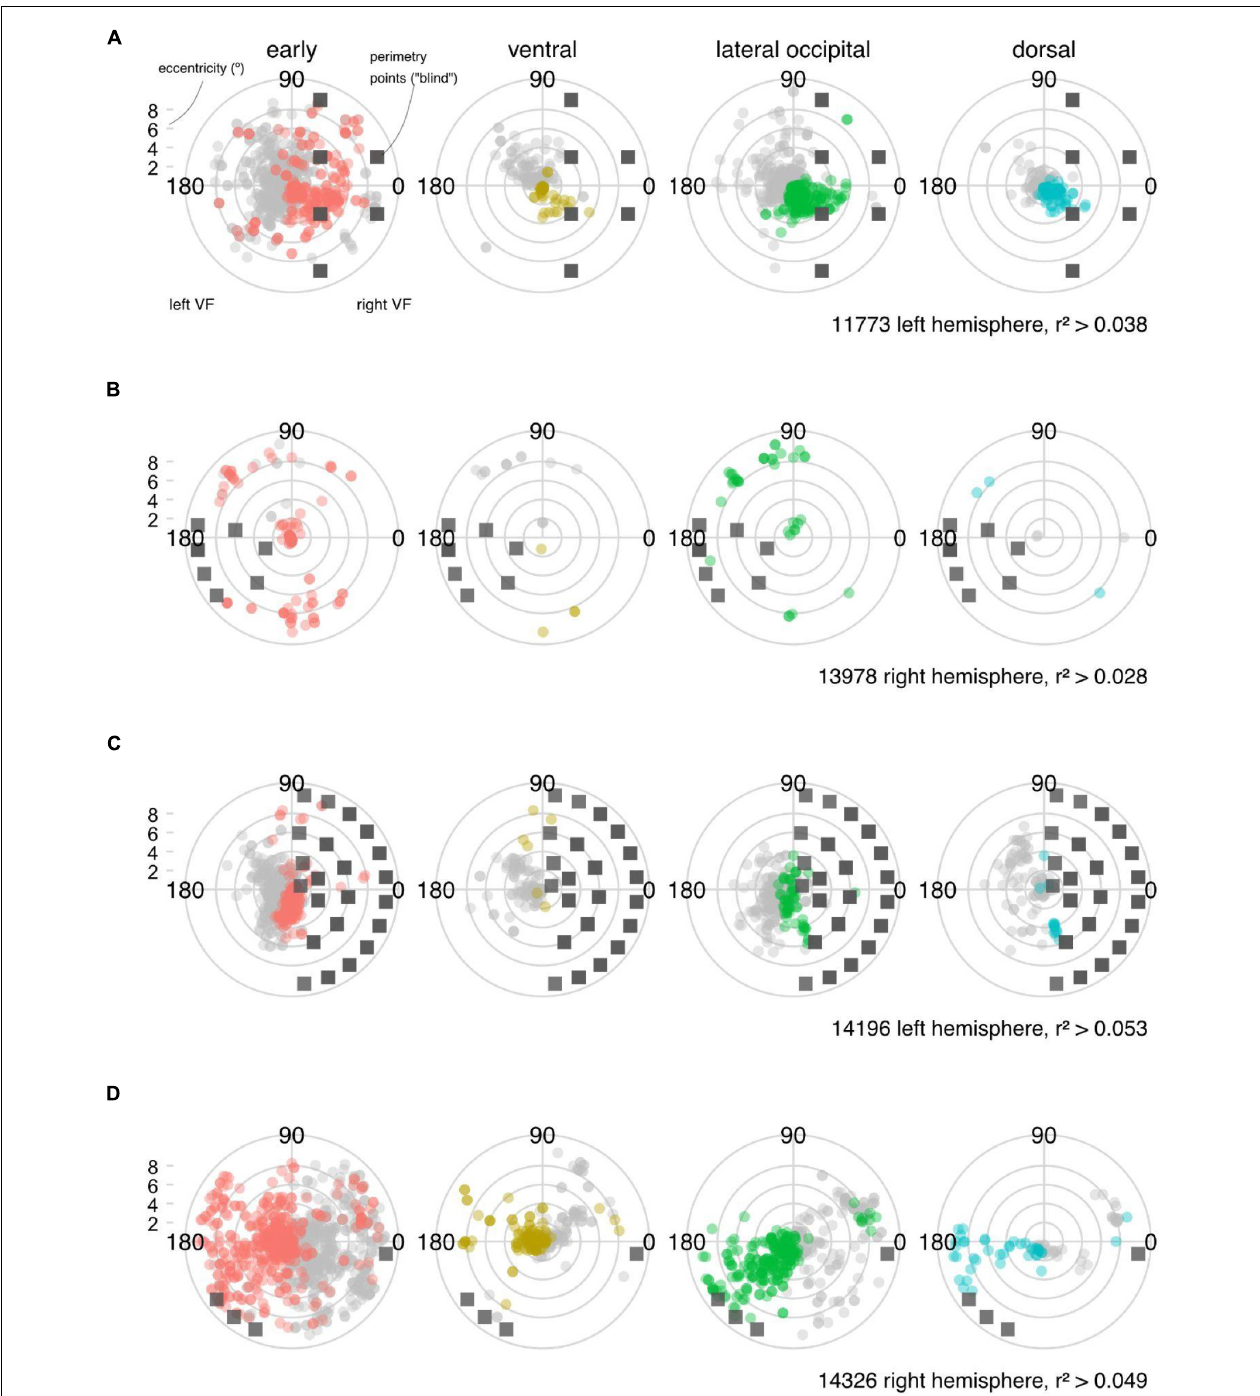
FIGURE 5 | Visual field maps derived from functional MRI and population receptive field (pRF) analysis. (A–D) Population receptive field (pRF) centers are plotted in polar coordinates for each participant to show the voxel representations in the visual field containing the scotoma. Note that in this plot, we only consider the centers of the pRFs that exceed an r 2 threshold determined in a control region. The scatter plot of pRF centers (colored symbols) is overlaid on the scotoma definition from perimetry (gray squares). Data for the ispi-lesional visual field (from the unaffected hemisphere are not shown in light gray symbols). Note that for participant 13978, fixation stability was an issue (and even with gaze-contingent microperimetry, acquiring robust data was challenging). For participant 14326, robust macular sparing was apparent in both standard and microperimetry. Despite this, the fMRI measurements still reveal a different pattern of loss (cf Table 3 and Supplementary Figures 1, 2